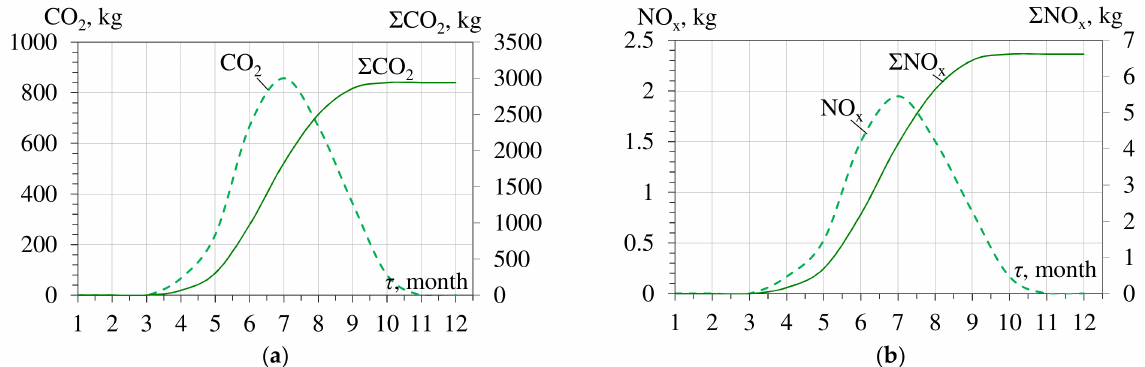
Figure 12. Monthly CO 2 and annual Σ CO 2 ( a ) and monthly NO x and annual Σ NO x ( b ) emission reduction due to engine inlet air cooling in AECh (Mykolayiv, southern Ukraine, 2017).